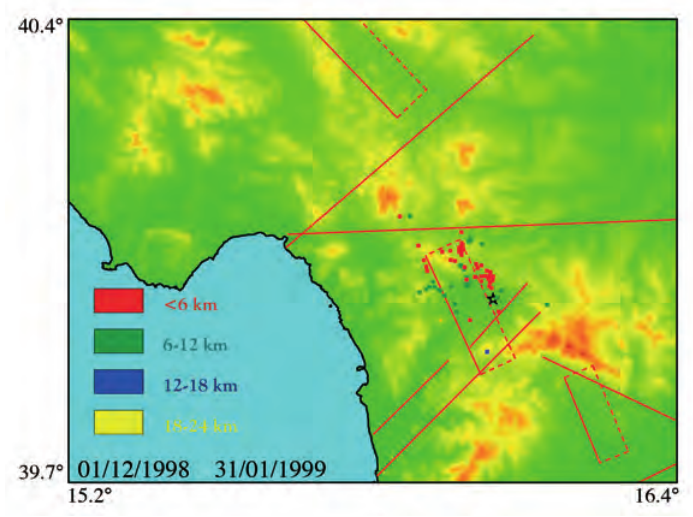
Fig. 11. Event locations in the time interval